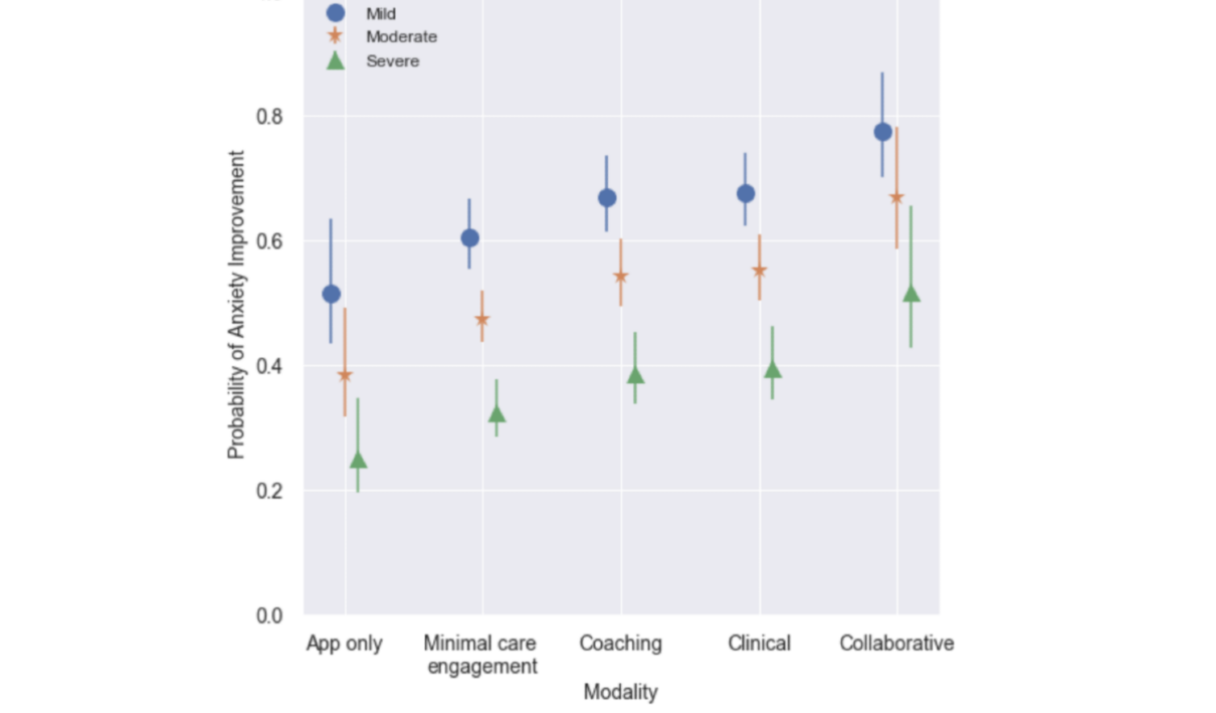
Table 4. Associations between utilization and improvement among the text-based coaching-only cohort (n=936).